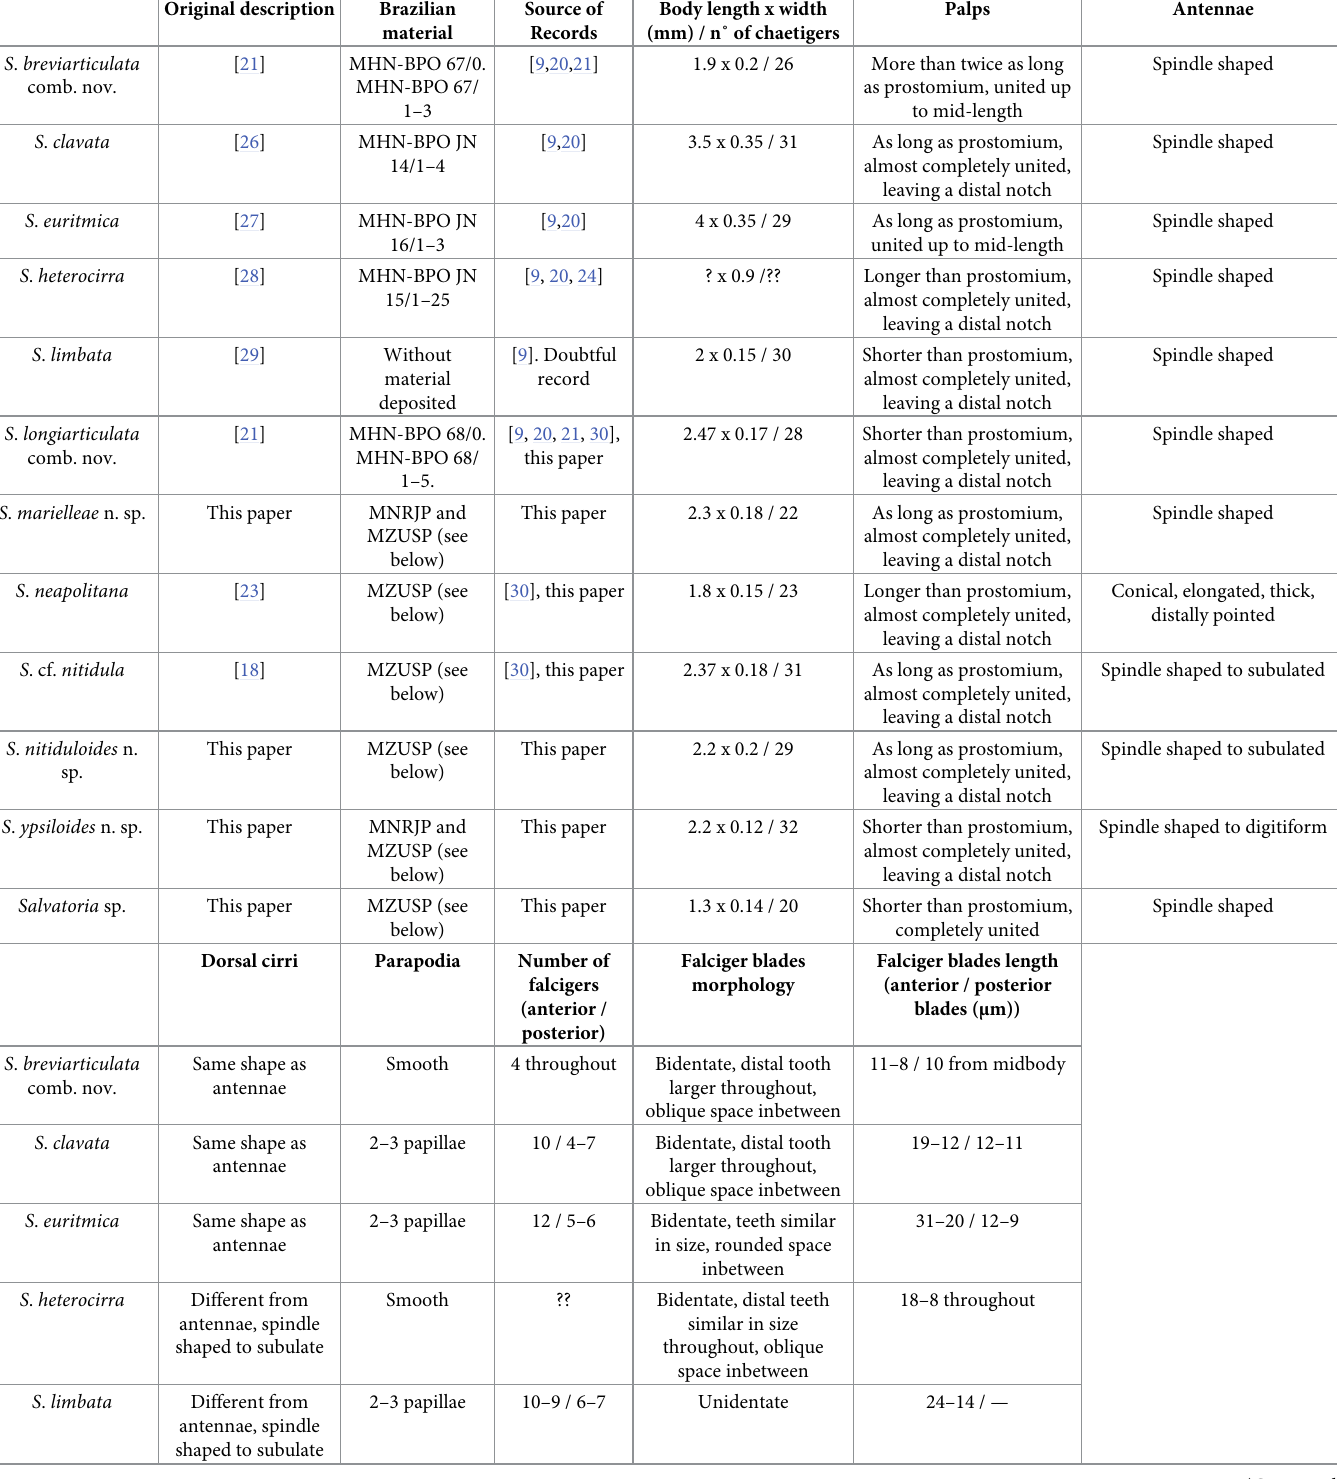
Table 1. Taxonomic and biogeographic data on the species of Salvatoria recorded for Brazilian waters, with reference to voucher